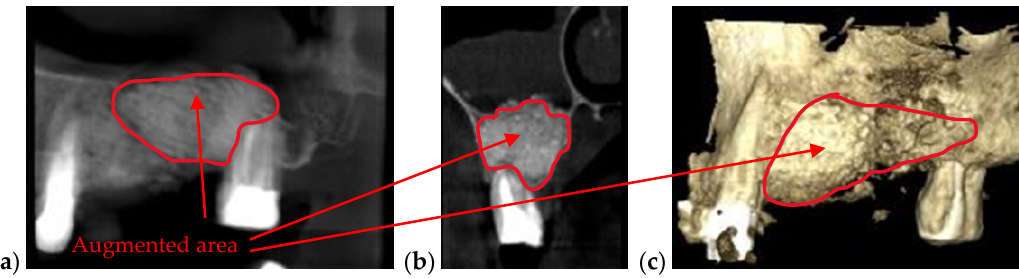
Figure 6. ( a ) Panoramic view, ( b ) sagittal view, and ( c ) 3D reconstruction of an augmented bone obtained after a segmental 3D CBCT with a FOV of 5 × 5 cm. Patient P.P., male, age 46 years, diagnosed with severe periodontitis.